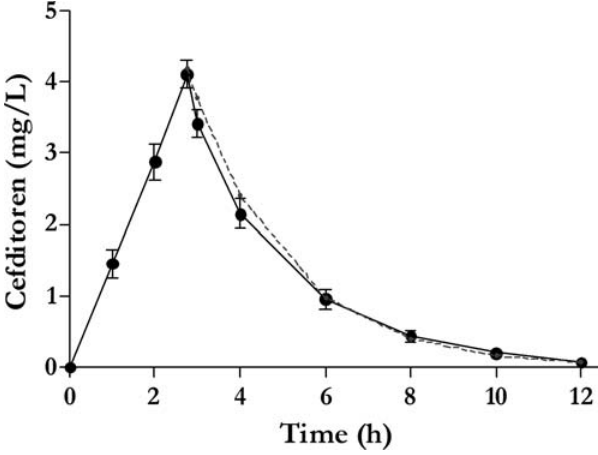
Figure 1. Cefditoren concentrations: Mean 6 SD target (grey dotted line) and experimental (black line) concentrations in the simulations.